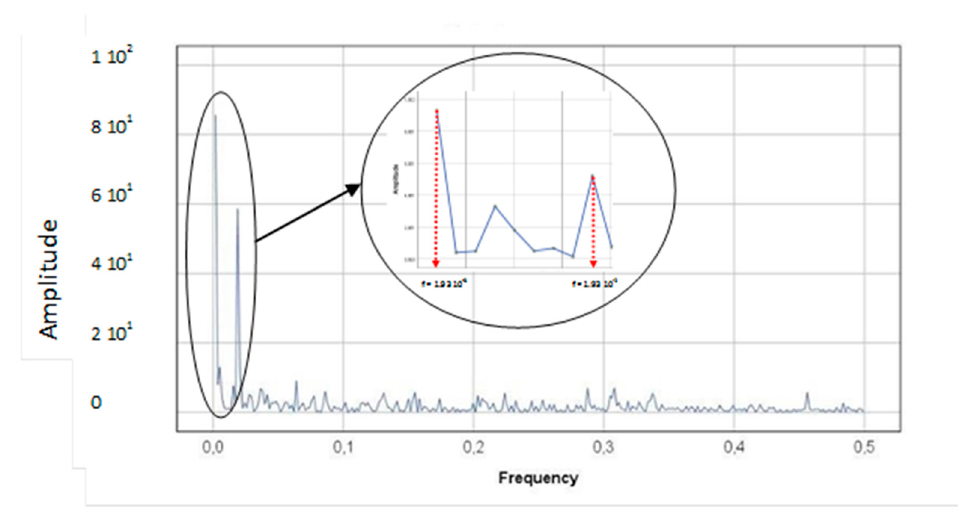
Figure 5. Periodogram for Bilbao time series of 7 Be activity concentrations from 2009 to 2018.